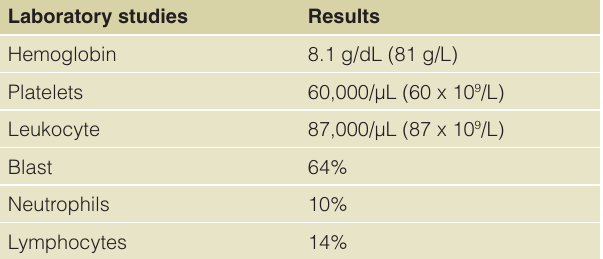
Table 1. Complete blood count with differential.